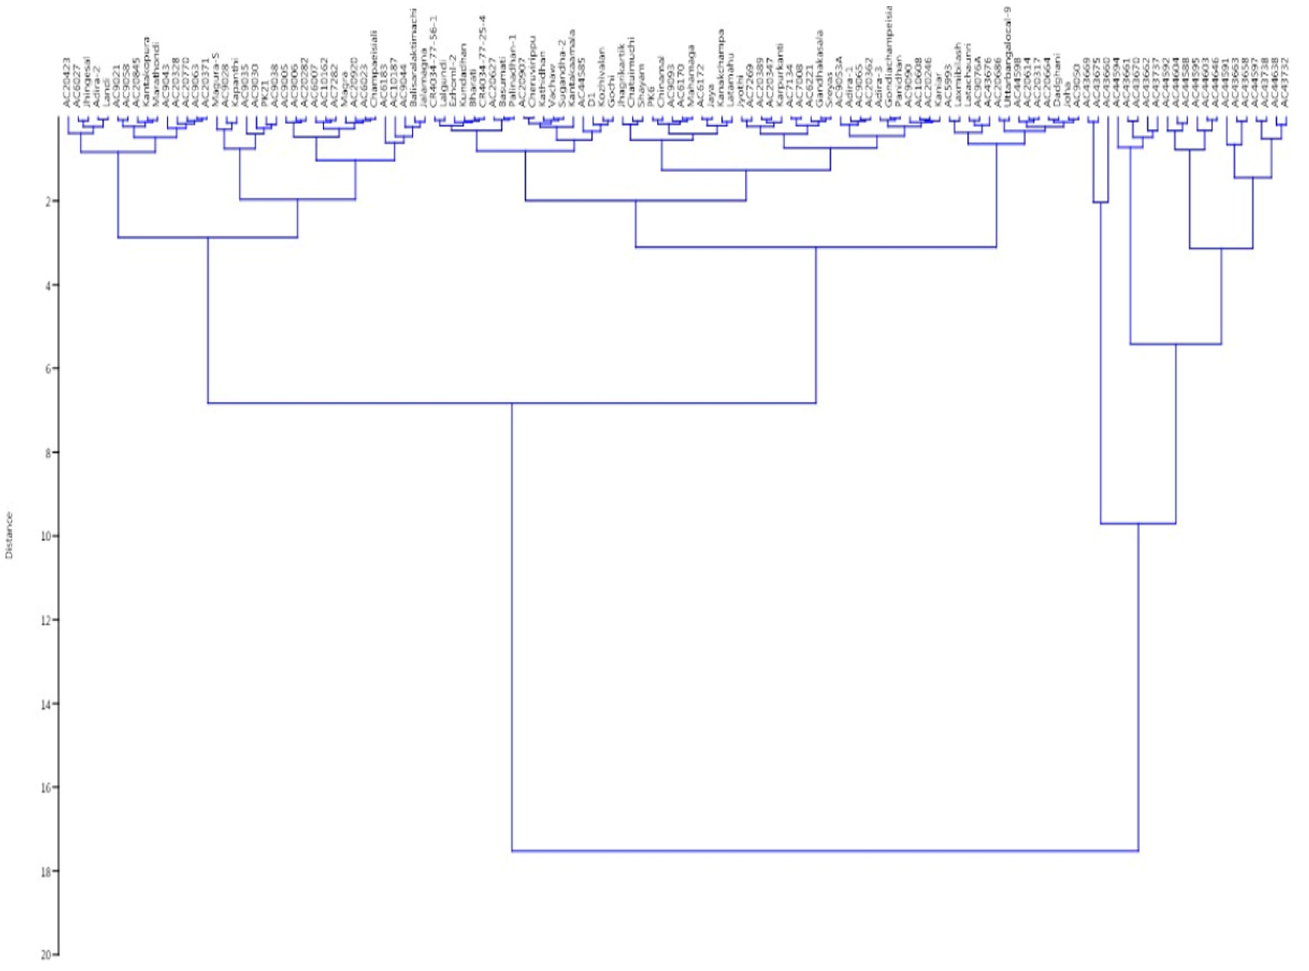
Figure 8. Wards’ clustering based on the estimates of 4 physiological traits for clustering of 124 germplasm lines. 124 germplasm